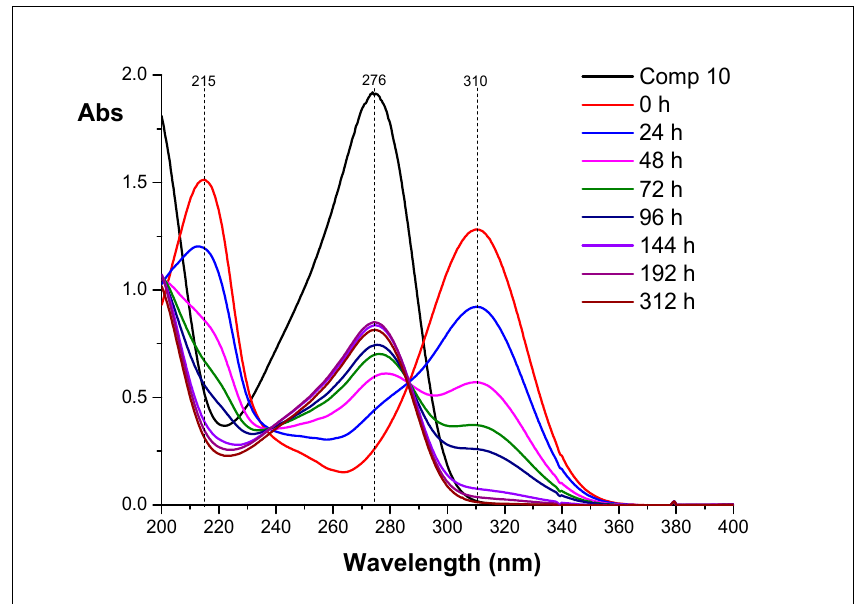
Figure 9. The UV spectra of reaction mixtures obtained during hydrolysis of 14 (D 2 O, appeared pH 4.1).